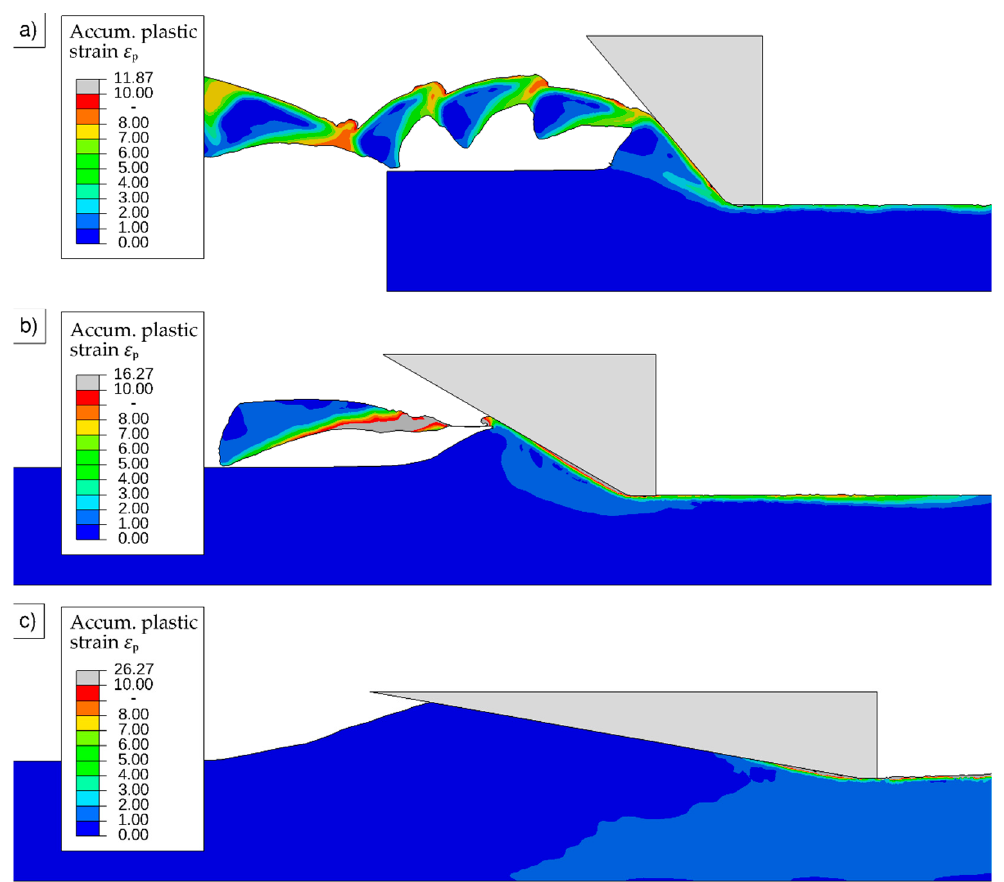
Figure 8. Chip formation for different rake angles γ s : ( a ) γ s = − 40 ◦ , ( b ) γ s = − 60 ◦ and ( c ) γ s = − 80 ◦ . Colour plot indicates the accumulated plastic strain.